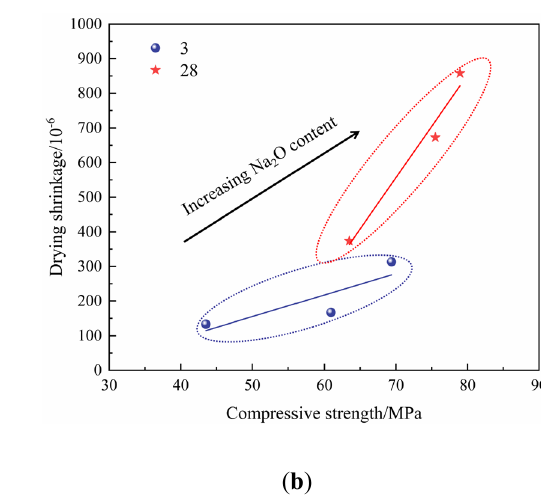
Figure 6. Relationship between compressive strength and drying shrinkage of AAMS composite cementitious materials. ( a ) Different slag contents. ( b ) Different Na 2 O contents. cementitious materials. ( a ) Different slag contents. ( b ) Different Na